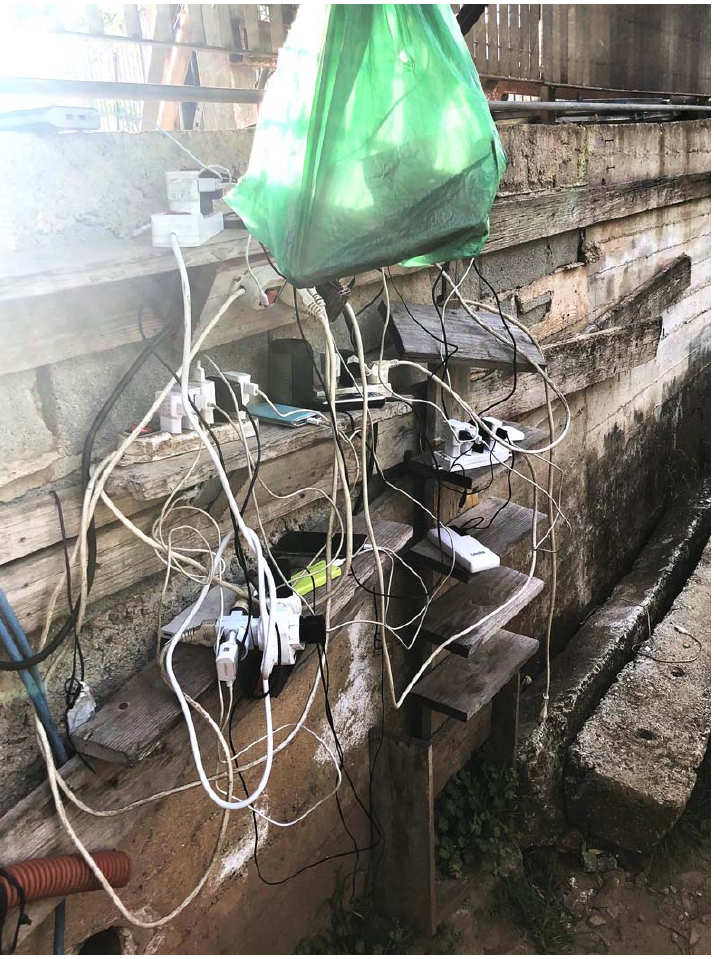
Figure 4. An electrical hub in a shack in the San Ferdinando settlement where residents charge their mobile phones.